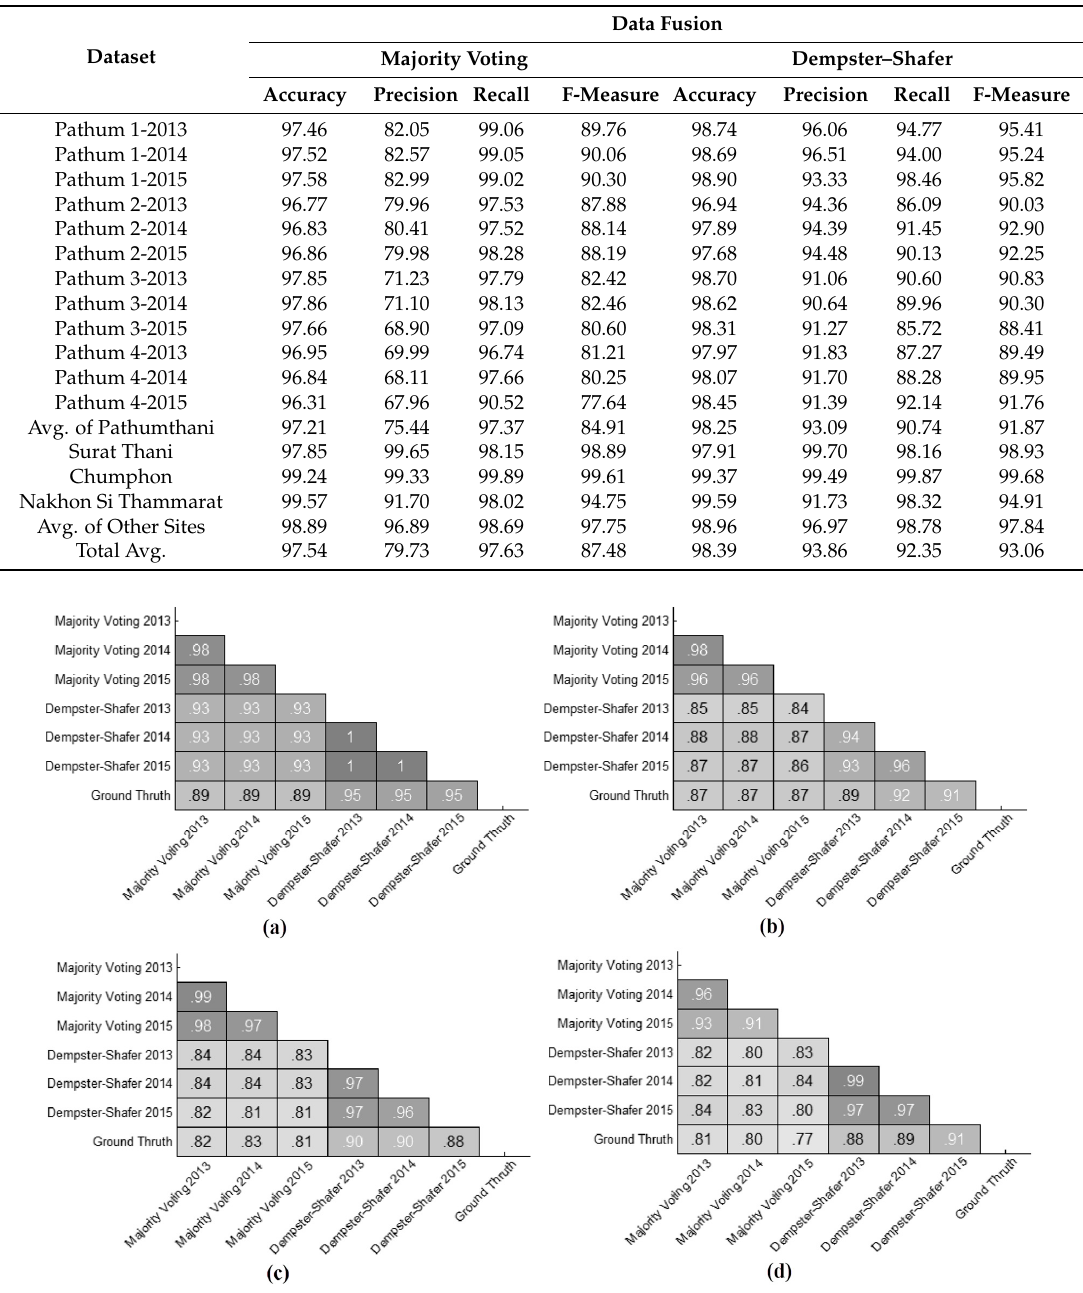
Table 3. Numerical assessment of Landsat with DSM fusion with four variables, including water indices and surface properties, with MMI-optimized thresholding.